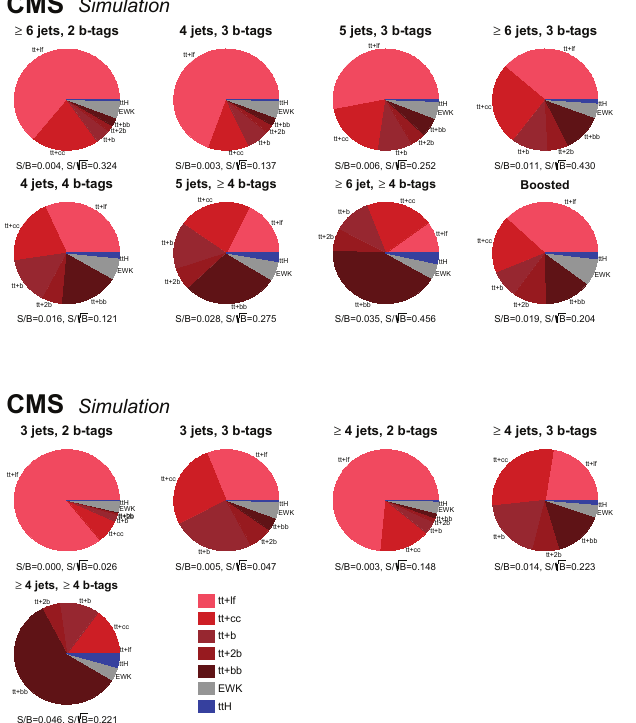
Figure 3. Fraction of processes contributing in the lepton + jets analysis categories [3].